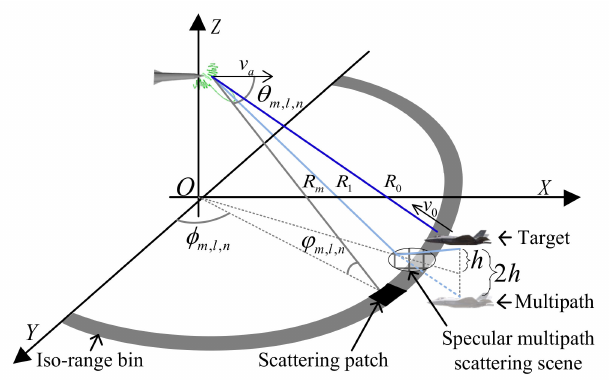
Figure 1. Geometric configuration of missile-borne